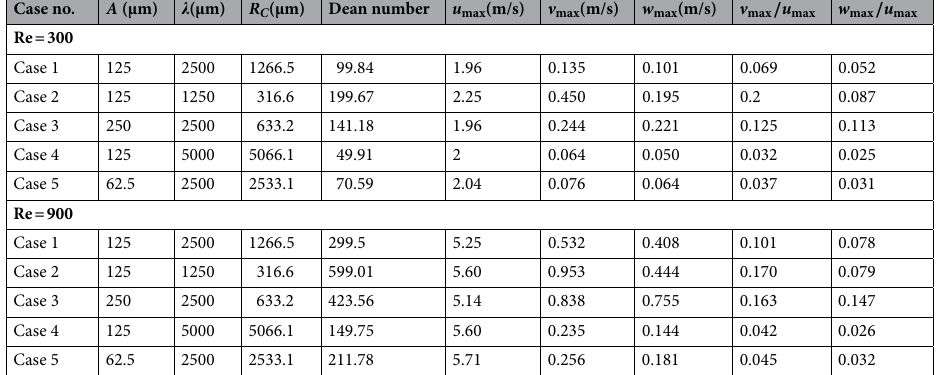
Table 6. Velocity components and velocity ratios for wavy cases in maximum velocity